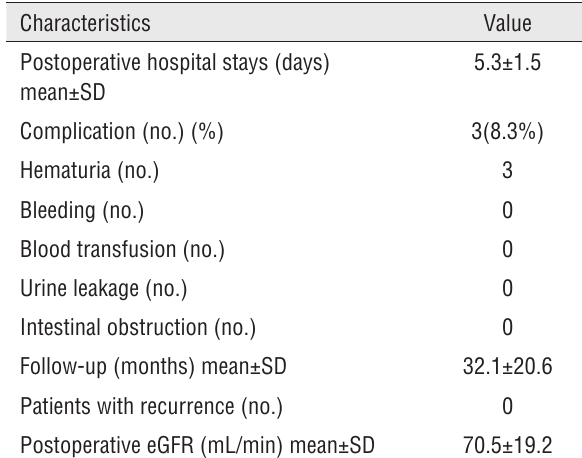
Table 4 - postoperative